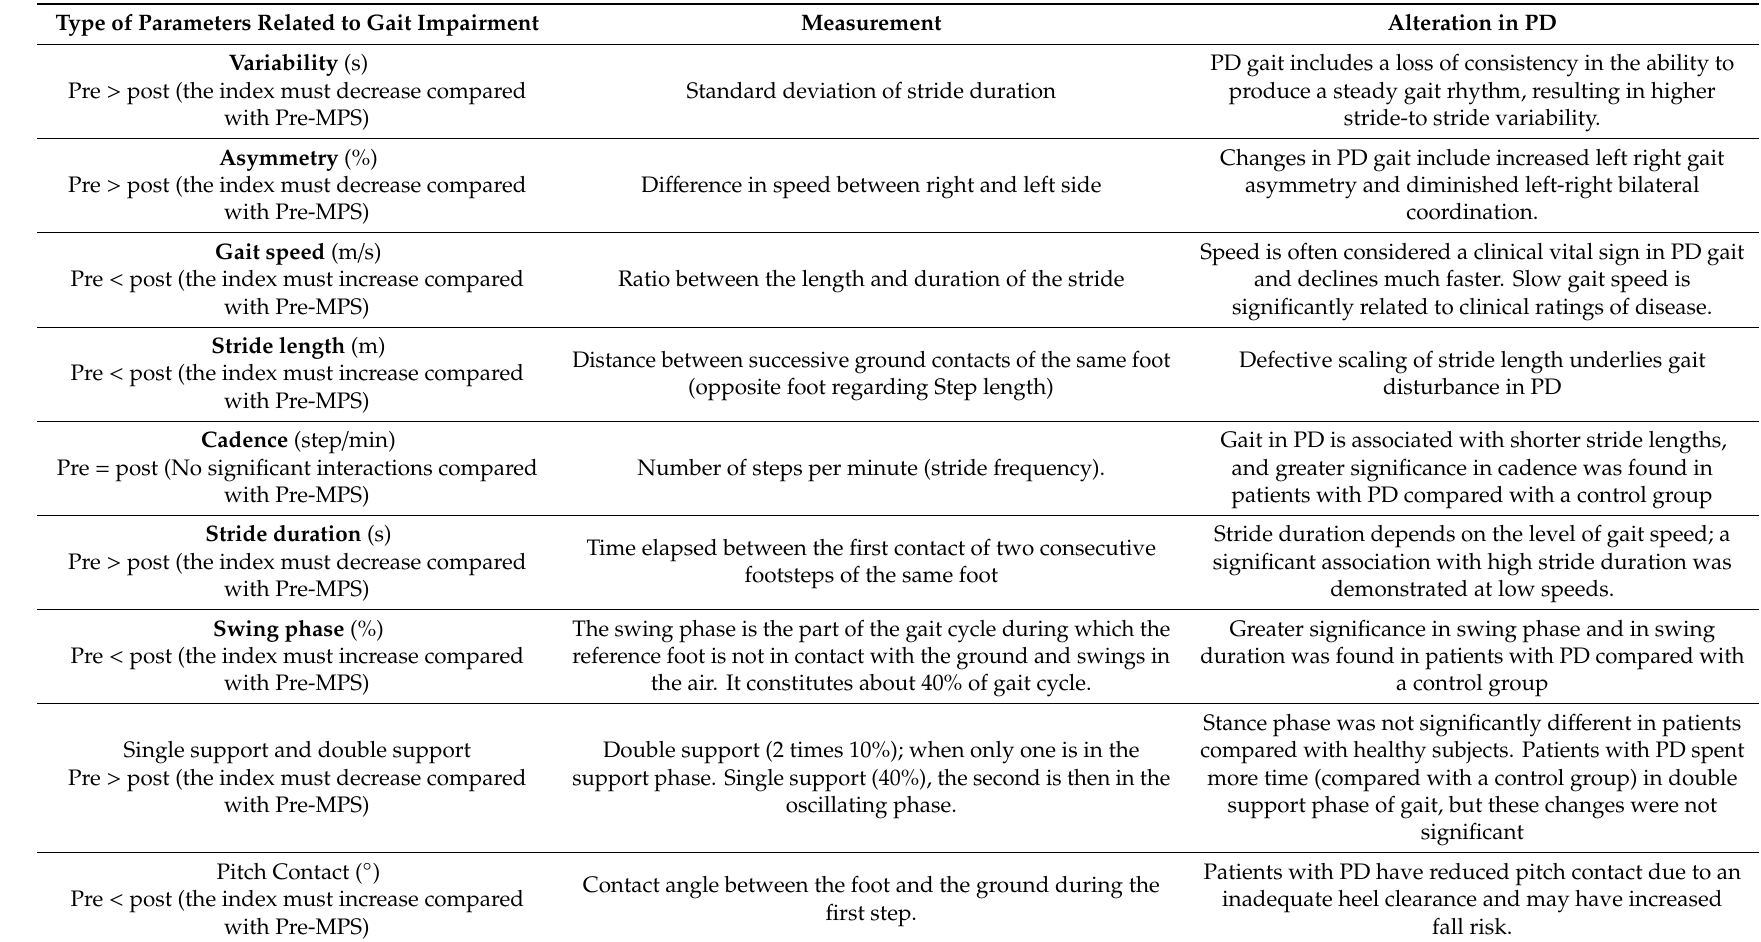
Table 1. Table showing all spatiotemporal parameters of interest